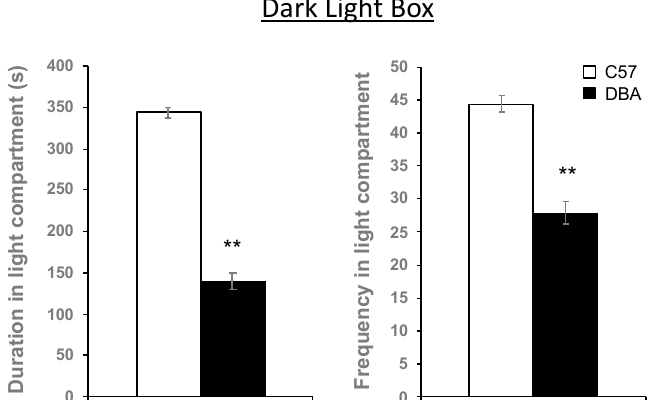
Figure 7. DBA mice show, in comparison with C57, increased anxiety levels in the dark light box. A significant di ff erence in time spent (duration) and in the number of visits (frequency) in the light compartment of the box was observed between DBA and C57, as depicted. Significant di ff erences are represented by t -test (2-tailed) ** p < 0.01. C57, n = 52; DBA, n = 61.